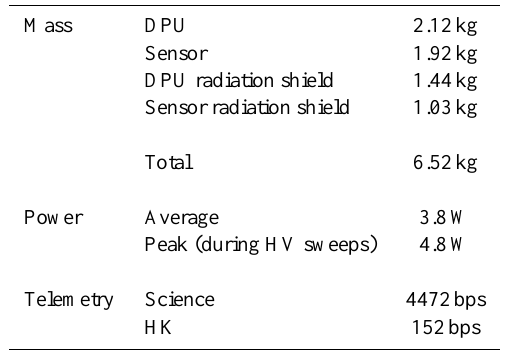
Table 1. Summary of resources used by a single Double Star PEACE